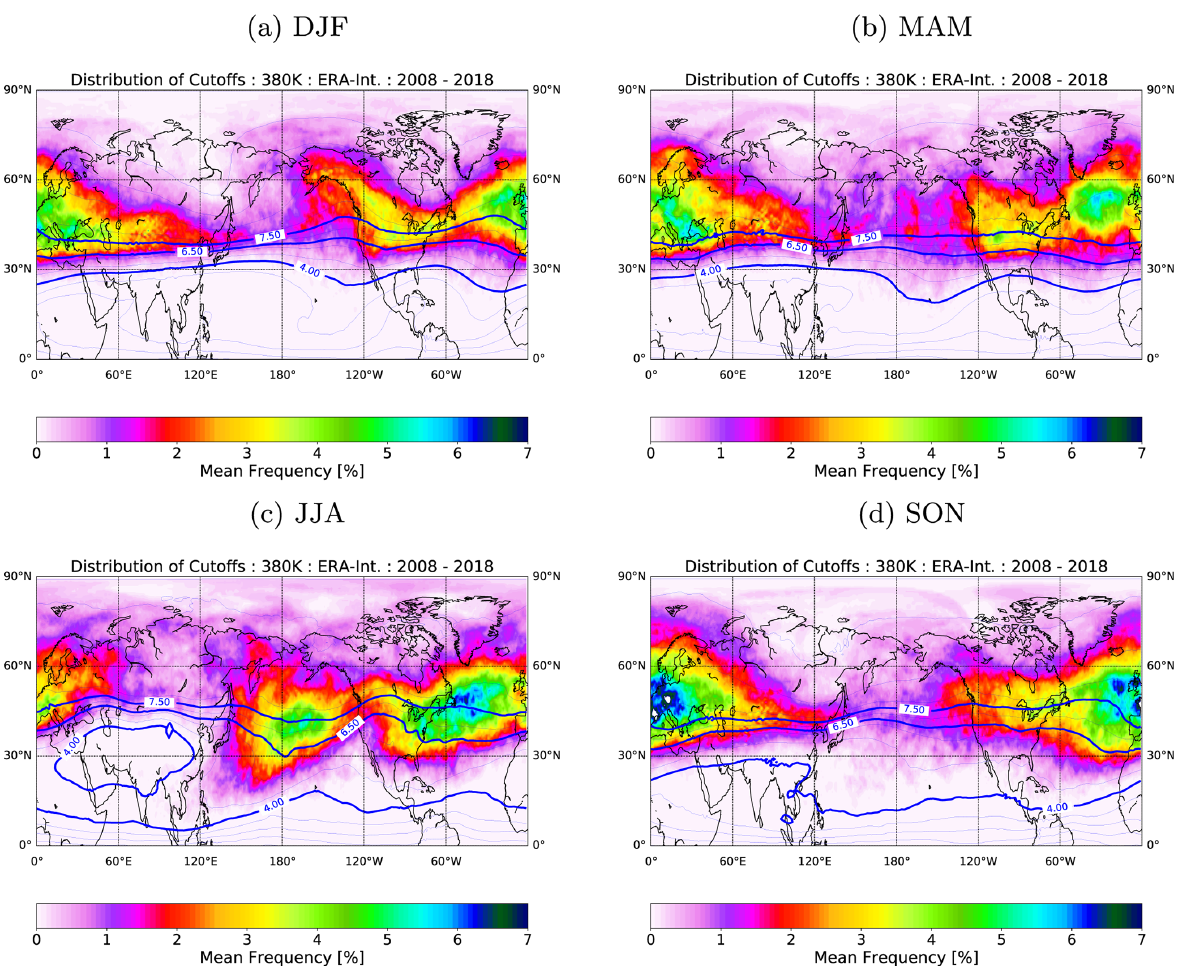
Figure 4. Global climatological frequency distribution of 6.5PVU cutoffs in the four seasons. A 1% mean frequency means that, in 1% of the time steps during a season, a cutoffs covers the